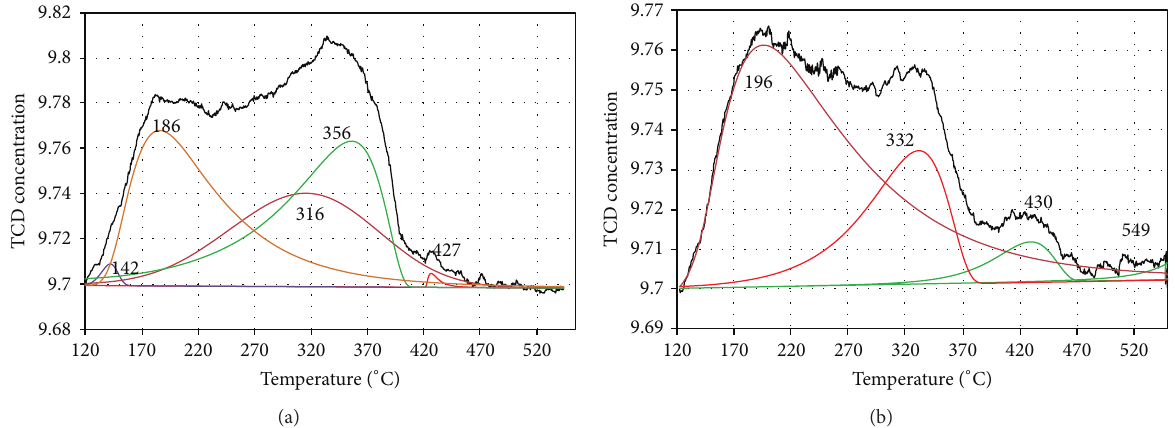
Figure 5: NH 3 -temperature programmed desorption profiles of the catalytic samples: (a) VT; (b) LaVT.